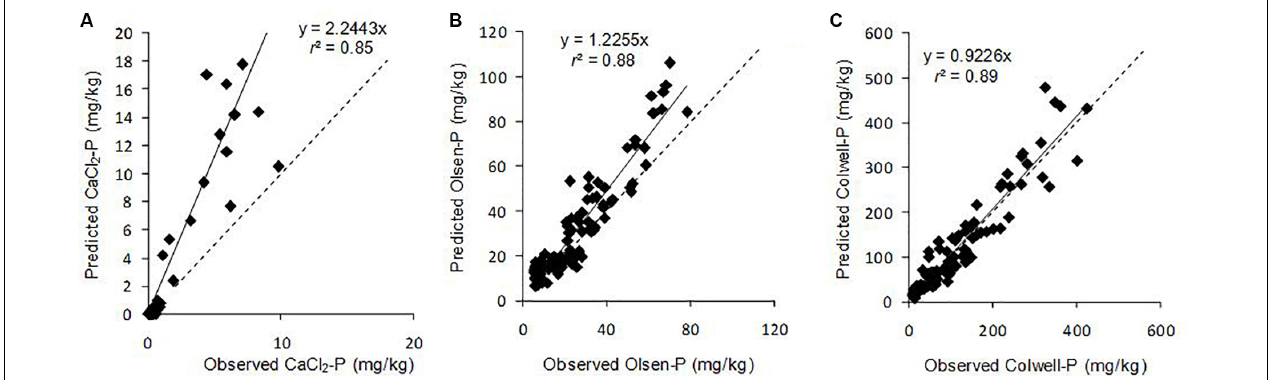
FIGURE 1 | Relationship between observed and predicted final (A) CaCl 2 -P, (B) Olsen-P, and (C) Colwell-P concentrations of the surface 10 cm for six Australian grazed pasture soils and all P init concentrations and P ferts . Solid line is the fitted regression and dashed line represents x = y . Points above the dashed line represent overestimation of P final concentration (modelled P final concentration greater than actual P final ), while points below represent underestimation of P final